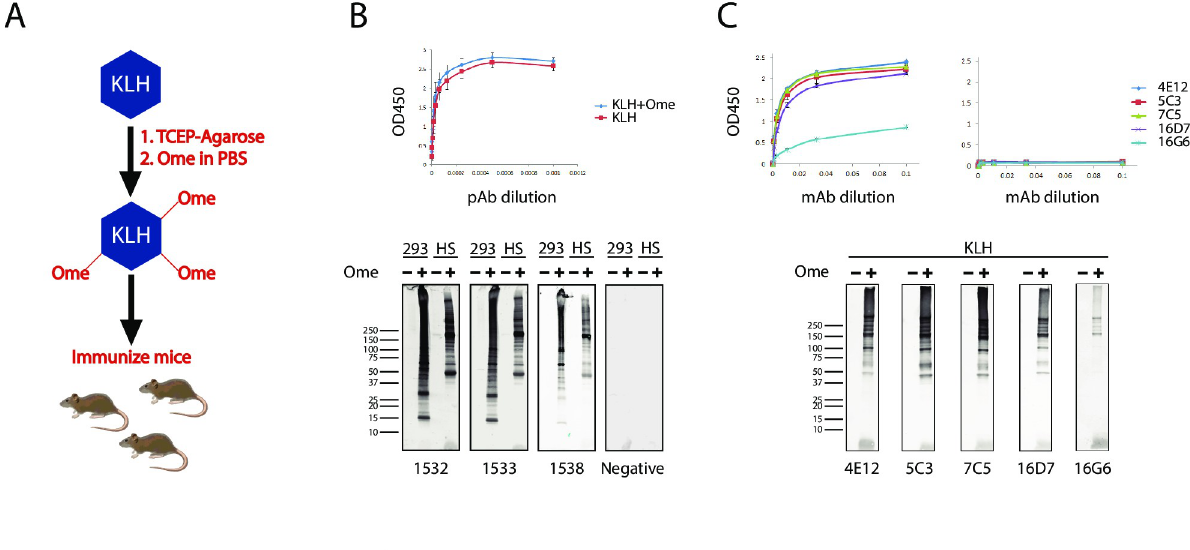
Fig 1. Strategy for generation of Ome-protein monoclonal antibodies. (A) KLH was reduced by TCEP agarose beads and then reacted with omeprazole to generate Ome-KLH complexes. This immunogen was then injected into 5 BALB/C and 5 C57BL/6 using a standard immunization protocol. (B) Polyclonal sera (pAb) from immunized mice contained high titers of antibodies that reacted with both KLH and Ome-KLH (ELISA results from all animals immunized; top panel); polyclonal antibodies reacted with HEK293 cell lysates (293) or human serum proteins (HS) treated with 2mM omeprazole for 2 hours at 37˚C but not untreated protein. No reaction was observed for non-immune serum. (C) Monoclonal antibodies specifically recognize Ome-KLH. ELISA analysis shows five independent monoclonal antibodies that reacted with Ome-KLH (left) but not KLH alone (right). Reduced KLH was prepared as above and incubated with 2mM omeprazole for 2 hours at 37˚C. Western blot analysis also indicates that monoclonal antibodies are specific for Ome-KLH (bottom panels). Samples for SDS-PAGE gel running were boiled in sample buffer without reducing agents. Antibody dilutions were 1:50 for Western blots. Molecular weight marker specifically represents the 4E12 blot.